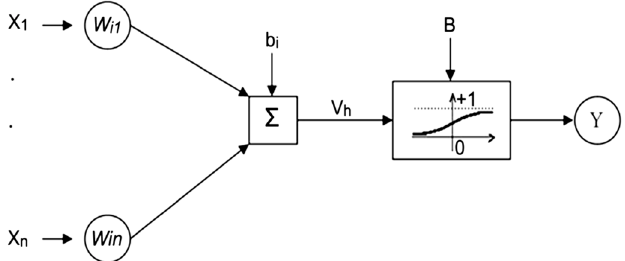
Figure 3. Basic representation of a Multilayer Perceptron Neural Network.